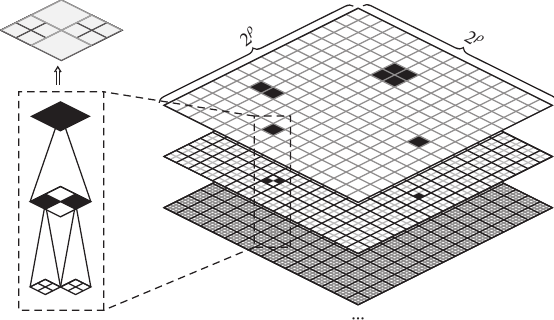
Figure 2: An example of the hybrid layers represent the corresponding spatial regions of the quad-tree nodes at various levels, where the black nodes represent further subdivided regions. The left part of the